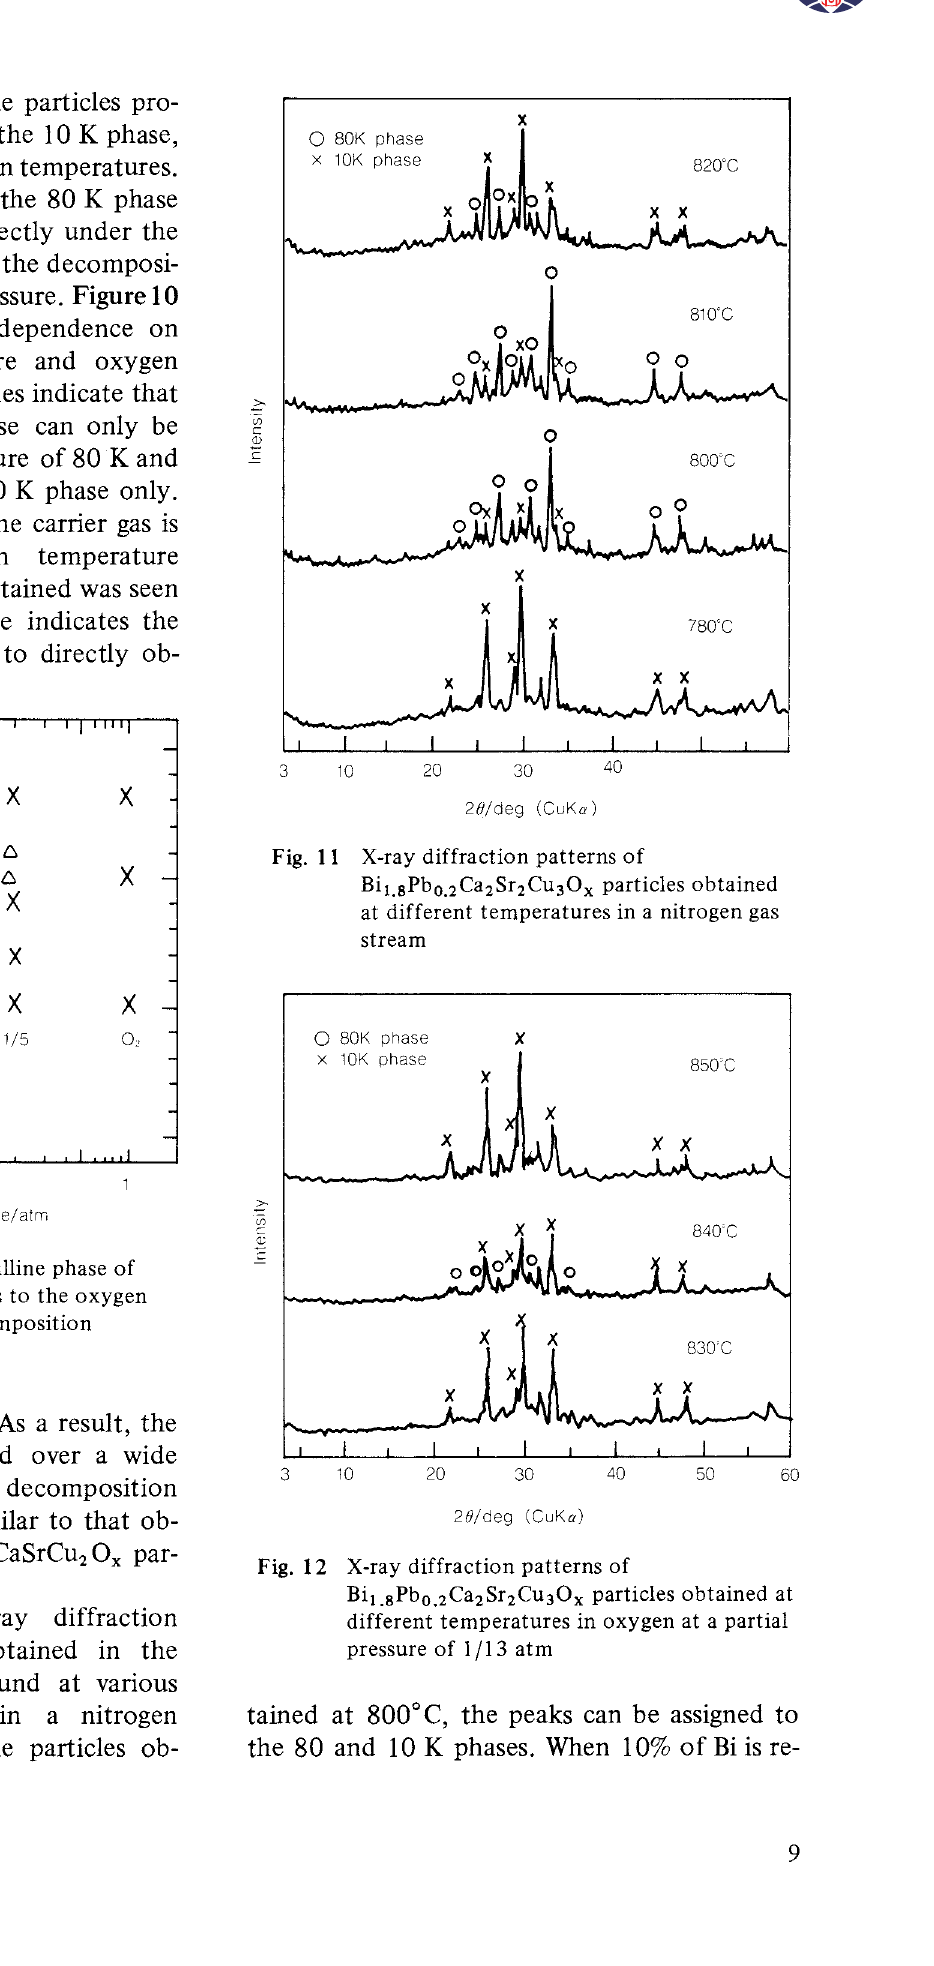
Figure 11 shows the x-ray diffraction patterns of the particles obtained in the Bi1.sPbo.2Ca 2 Sr 2 Cu 3 0x compound at various decomposition temperatures in a nitrogen stream. In the patterns of the particles ob-